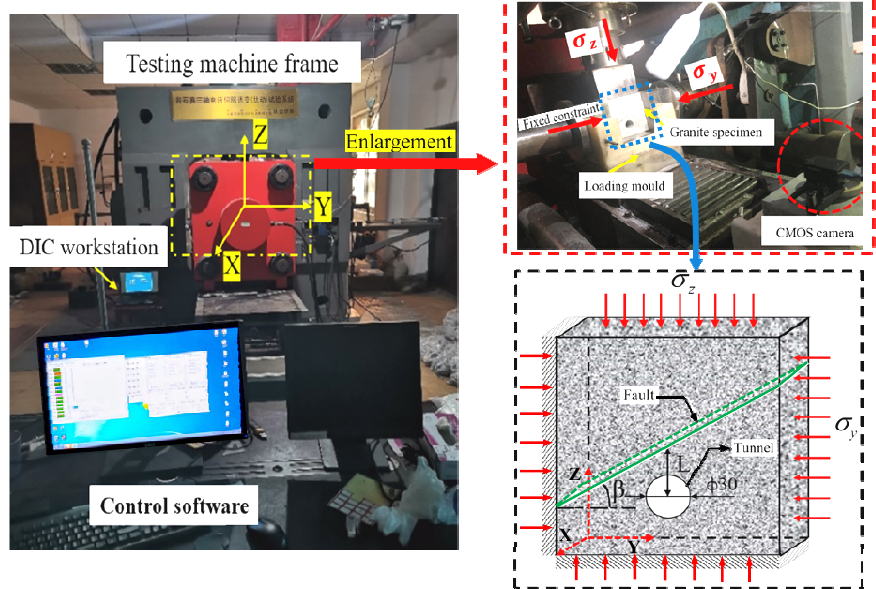
Figure 3. True ‐ triaxial testing equipment and schematic diagram of the loading method for the